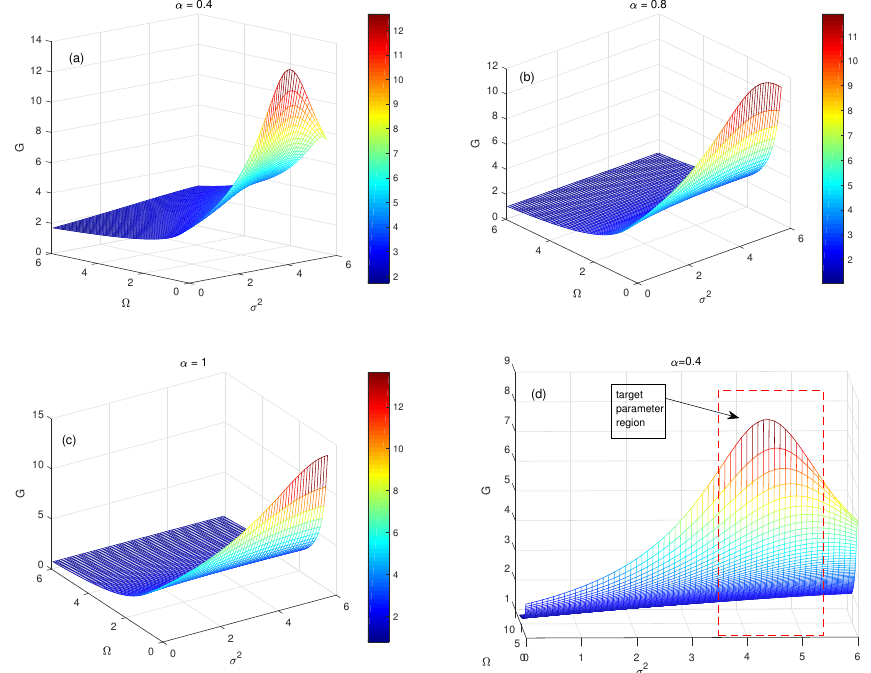
Figure 4. Three-dimensional plots of the output gain G as a function of the driving frequency Ω and the noise intensity σ . The values of the parameters are set as: ω = 1 and λ = 5, and the other parameters are ( a ) α = 0.4, ( b ) α = 0.8, ( c ) α = 1, ( d ) α = 0.4 with target parameter